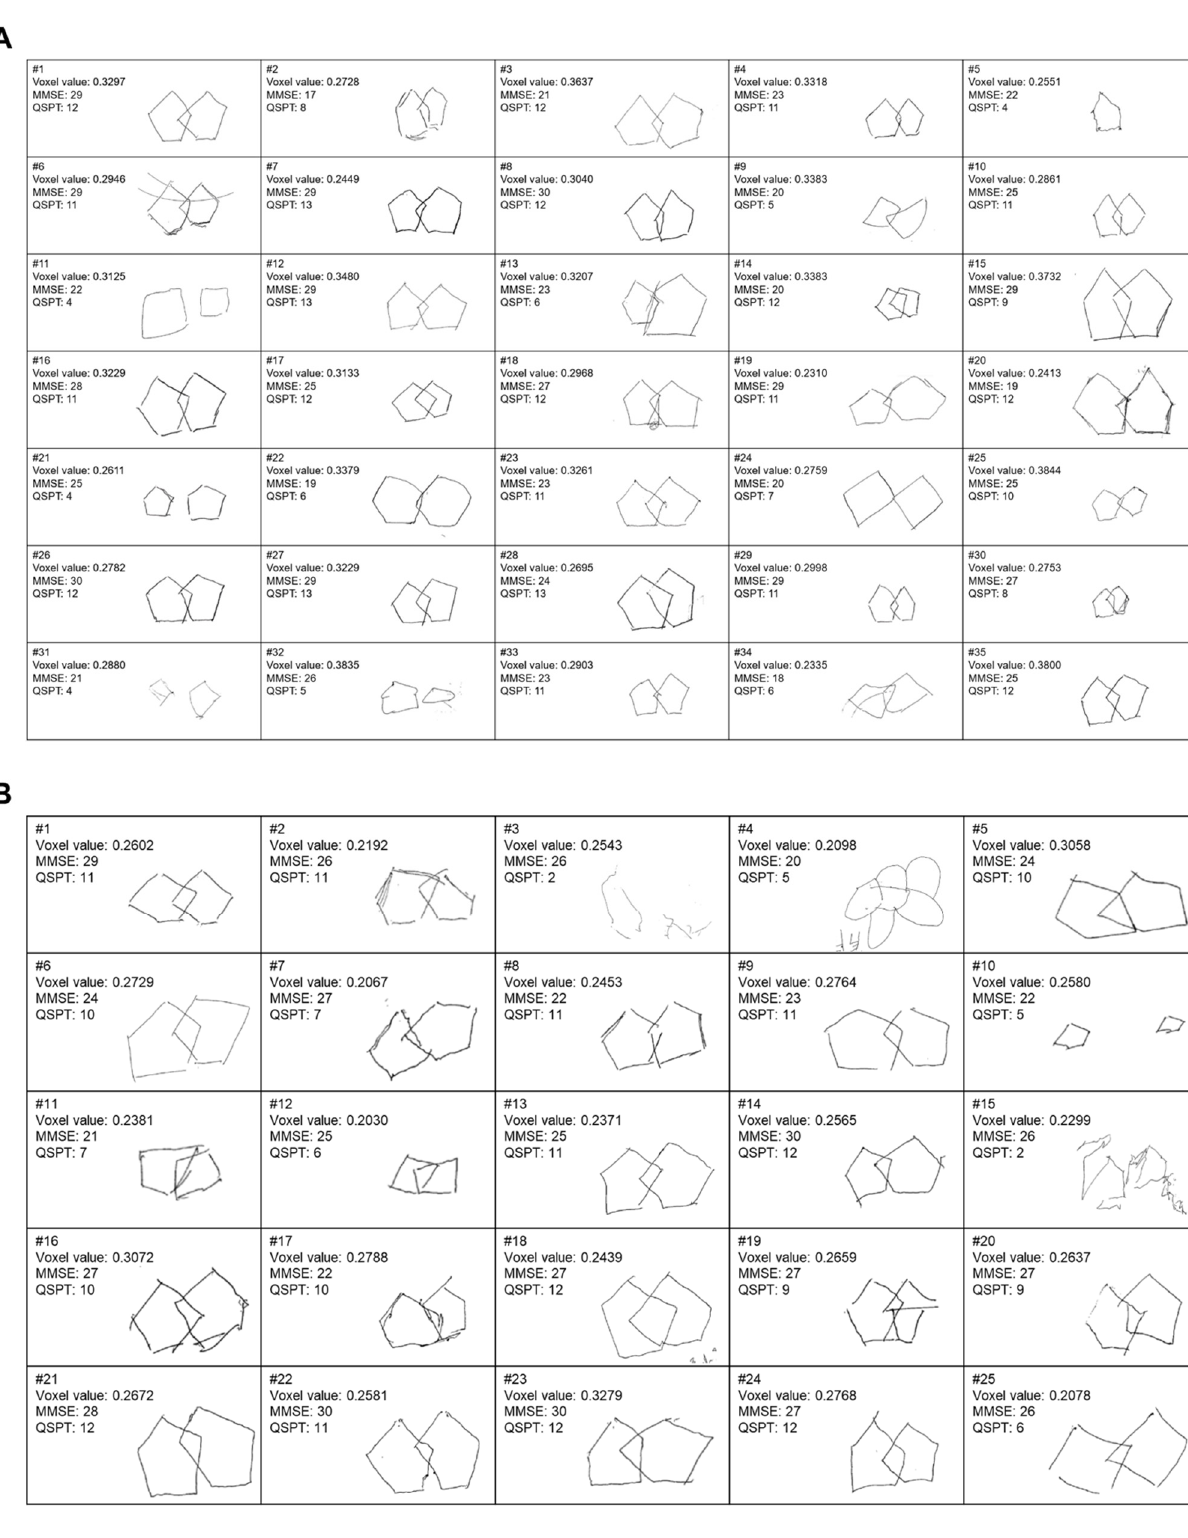
Figure 2. Individual results of Mini-Mental State Exam (MMSE), Qualitative Scoring MMSE Pentagon Test (QSPT), and voxel values extracted from the right inferior temporal cortex cluster in Parkinson’s disease patients without orthostatic hypotension (OH) ( A ) and those with OH ( B ).